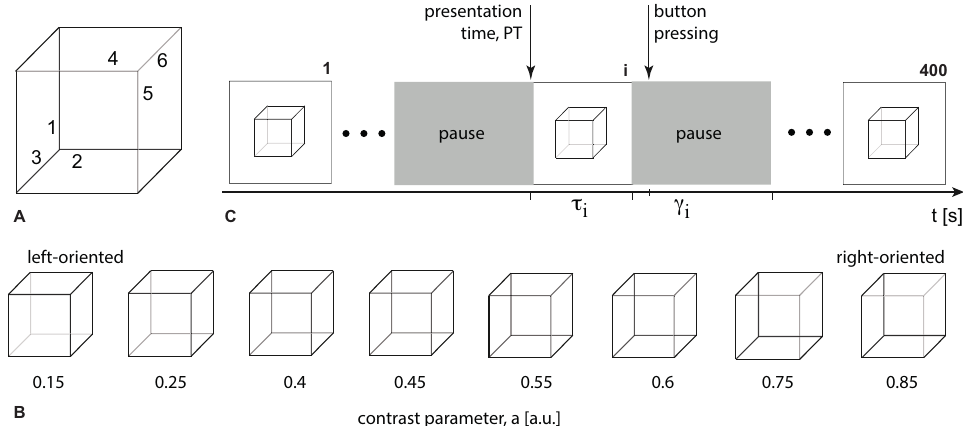
Figure 1. ( A ) An example of the Necker cube image with the labelled inner edges. ( B ) Visual stimuli (Necker cubes) with different values of the contrast parameter, a determining orientation, and ambiguity. ( C ) Scheme of the experiment. We presented 400 images, each presentation starts at the presentation time PT and lasts τ i ∈ [ 1,1.5 ] s. The pause time γ i varies from 3 to 5